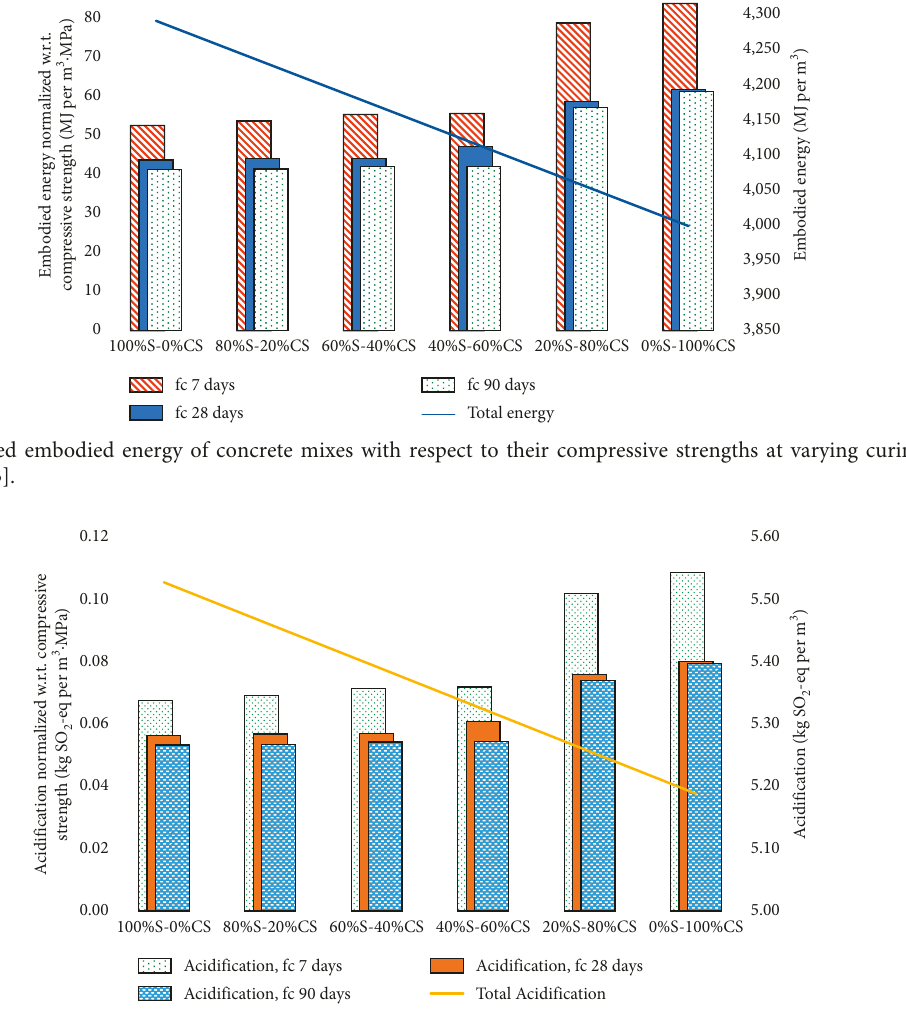
Figure 11: Normalized acidification of concrete mixes with respect to their compressive strengths at varying curing ages, GreenConcrete LCA tool [3].